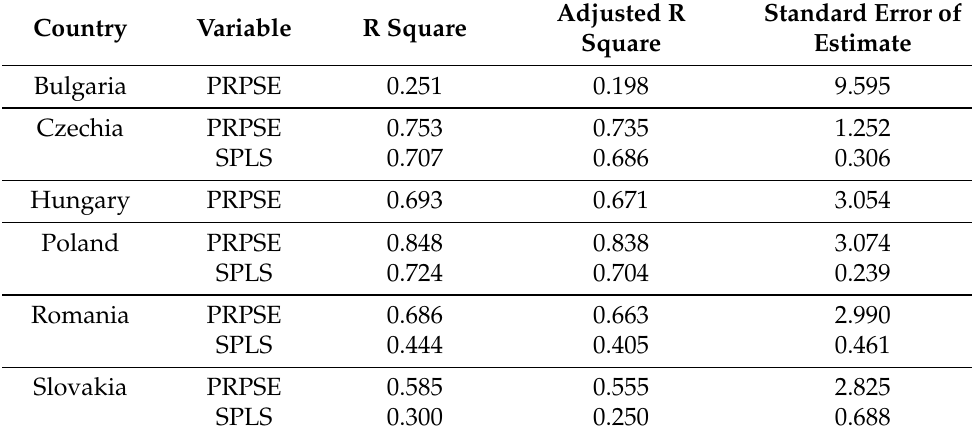
Table 5. R square, Adjusted R square and Standard error of